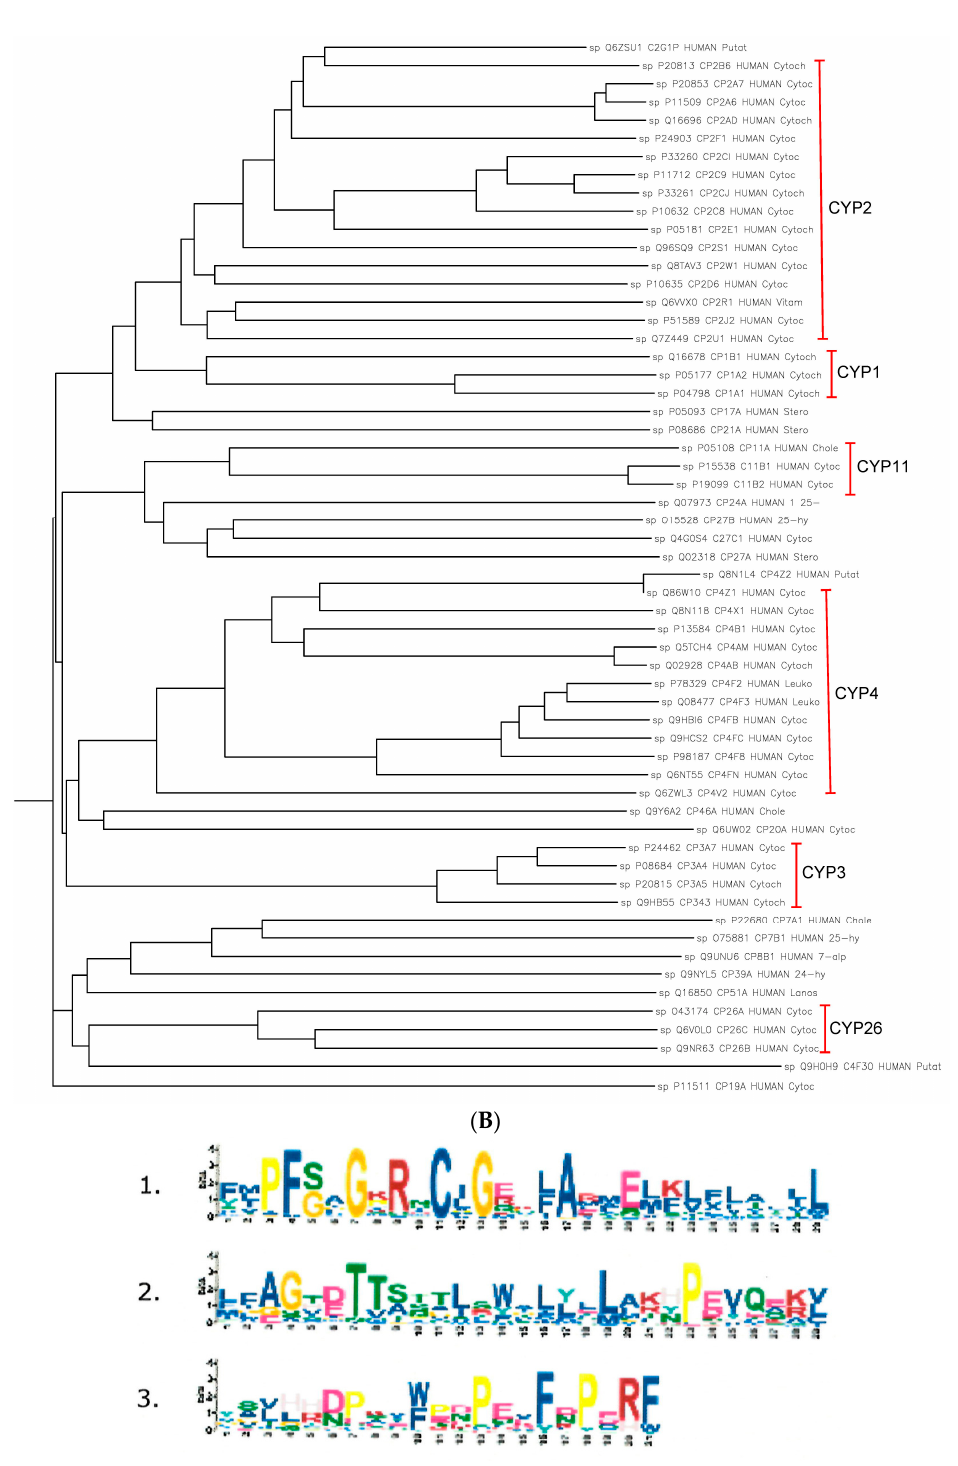
Figure 1. ( A ) Alignment of 57 human CYP proteins which are retrieved from Swiss-Prot. Multiple sequence alignment of human CYPs is carried out using Clustal W v2.0; ( B ) The phylogenic tree of human CYPs which can infer the evolutionary relationships among human CYPs; ( C ) MEME (Multiple EM for Motif Elicitation) version 4.10.1 is employed to identify important conserved motifs present in human CYP proteins.